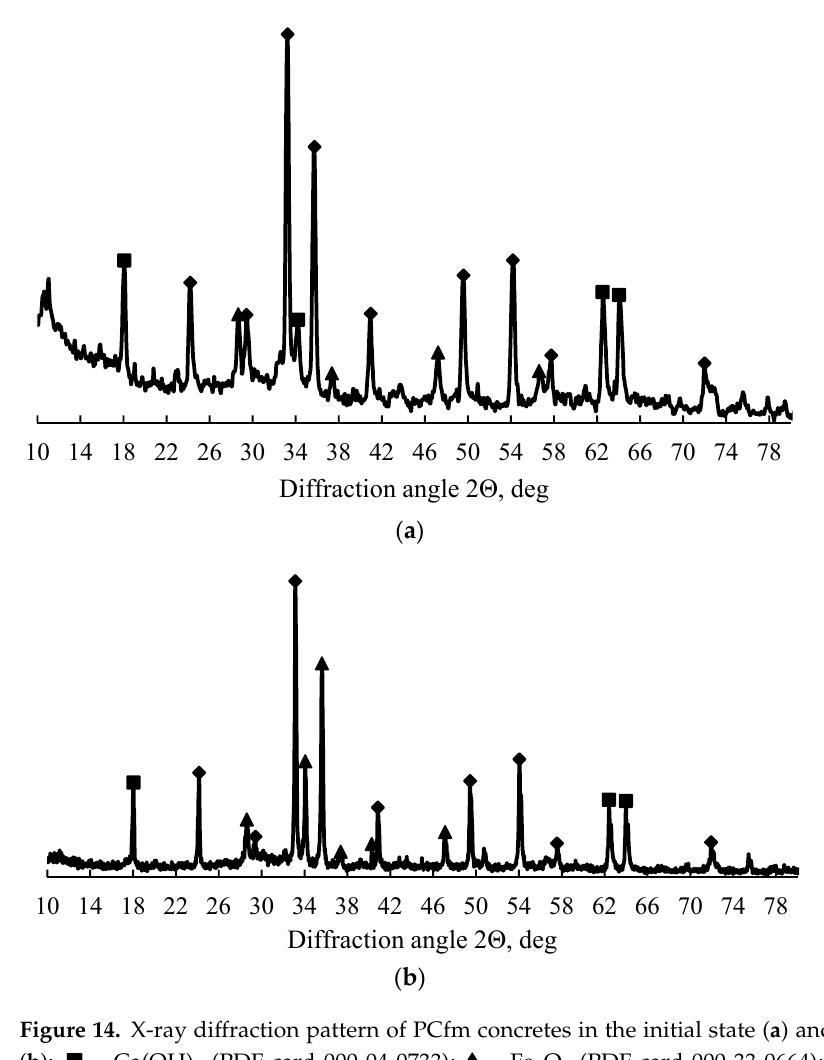
Figure 14. X-ray di ff raction pa tt ern of PCfm concretes in the initial state ( a ) and after irradiation ( b ): Figure 14. X-ray diffraction pattern of PCfm concretes in the initial state ( a ) and after irradiation ■ = Ca(OH) 2 (PDF card 000-04-0733); ♦ = Fe 2 O 3 (PDF card 000-33-0664); ▲ = MnO 2 (PDF card 000- ( b ): (cid:4) = Ca(OH) 2 (PDF card 000-04-0733); (cid:7) = Fe 2 O 3 (PDF card 000-33-0664); (cid:78) = MnO 2 (PDF 24-0735). card 000-24-0735). Table 3. Thermal e ff ects and mass losses during heating of PCf and PCfm concretes.